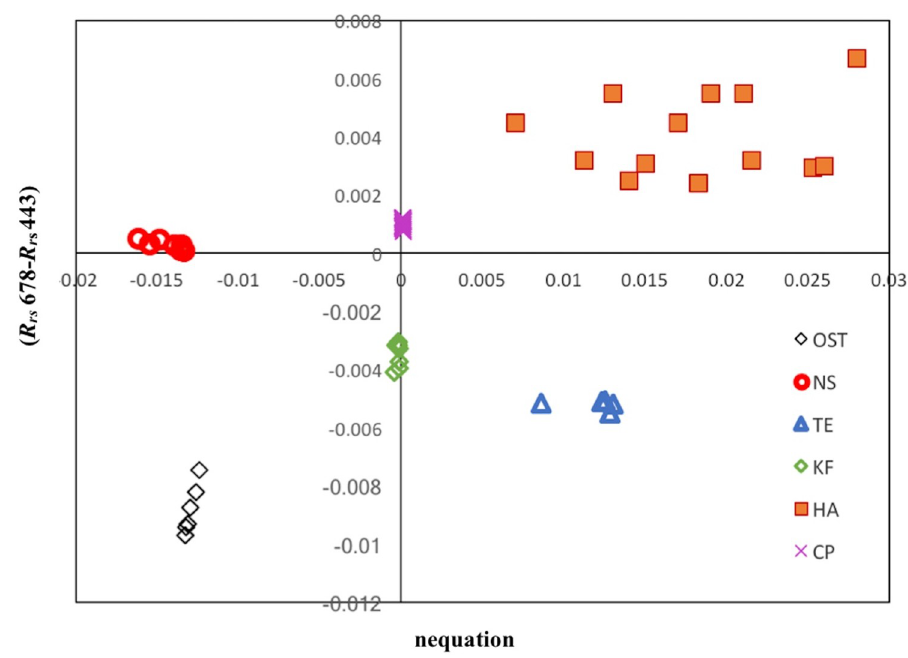
Fig 5. Distinct cluster of different HAB species (based on training datasets) in the Red Sea waters. Ost- Ostreopsis sp .; NS- N . scintillans/miliaris ; TE- T . erythraeum ; KF- K . foliaceum ; HA- H . akashiwo ; CP- C. polykrikoides